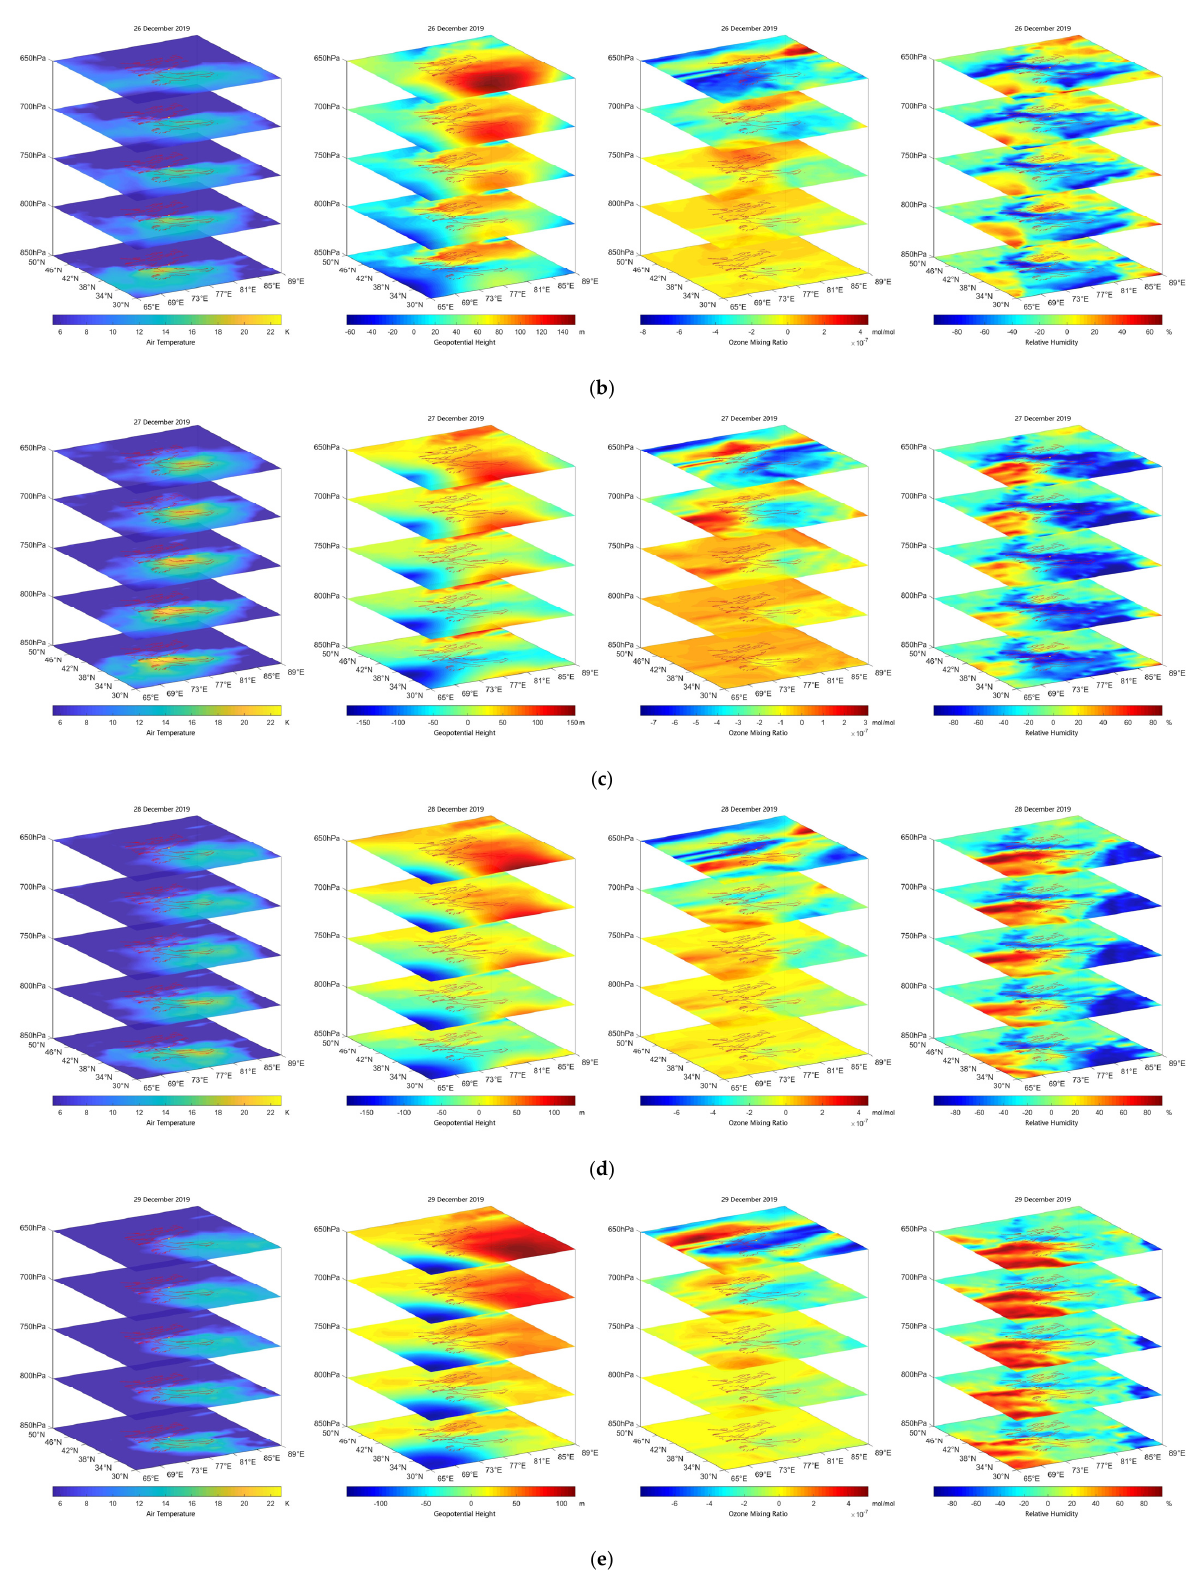
Figure A4. Composite atmospheric anomaly maps during atmospheric thermal anomalies associated with earthquake in Jiashi on ( a ) 25 December; ( b ) 26 December; ( c ) 27 December; ( d ) 28 December; ( e ) 29 December, 2019. The epicenter and faults are shown by yellow point and red lines, respectively. For each row, the subplots represent air temperature, geopotential height, ozone mixing ratio and relative humidity from left to